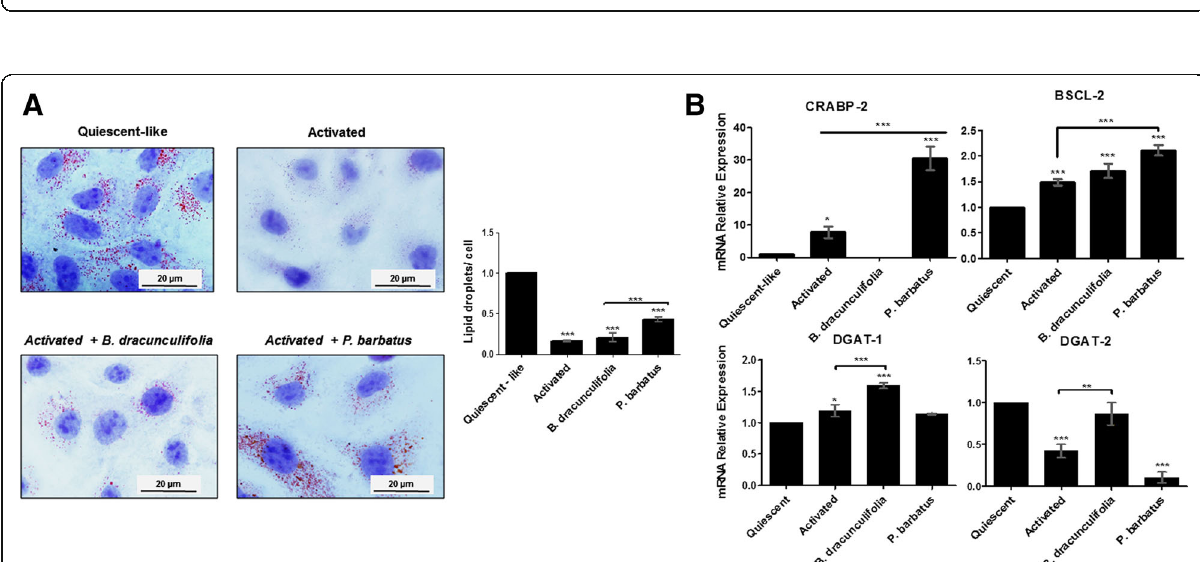
Fig. 2 Cellular and molecular effects of the medicinal plant extracts of Baccharis dracunculifolia and Plectranthus barbatus . ( a ) Fluorescence microscopy analyses of actin filaments in different groups of LX-2 after 24 h cellular treatments ( b ) Transcriptional level of pro-fibrotic markers in different groups of LX-2 cells by qRT-PCR. The graphs represent the mean values of at least three independent experiments ( p < 0.05)